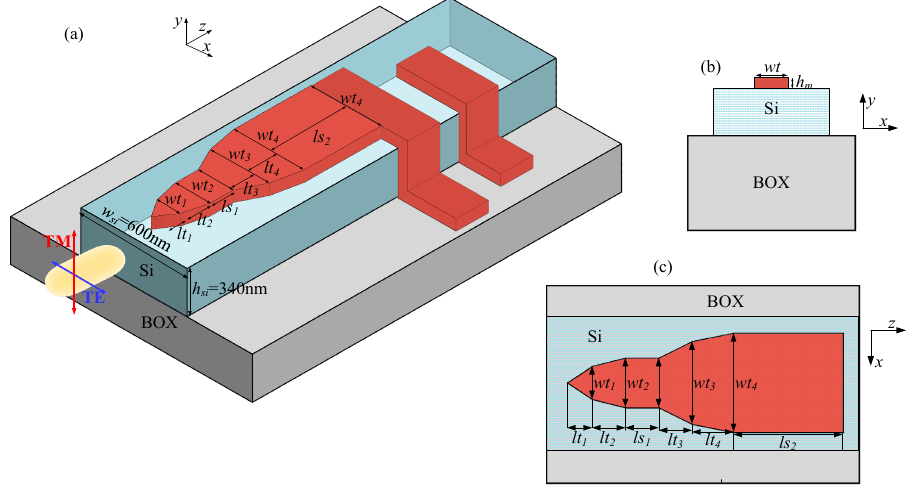
Figure 7. ( a ) The schematic configuration of a polarization-insensitive Schottky photodetector working in 2 µm wavelength band; ( b ) the cross section of the hybrid plasmonic waveguide; and ( c ) the top view of the absorption region.